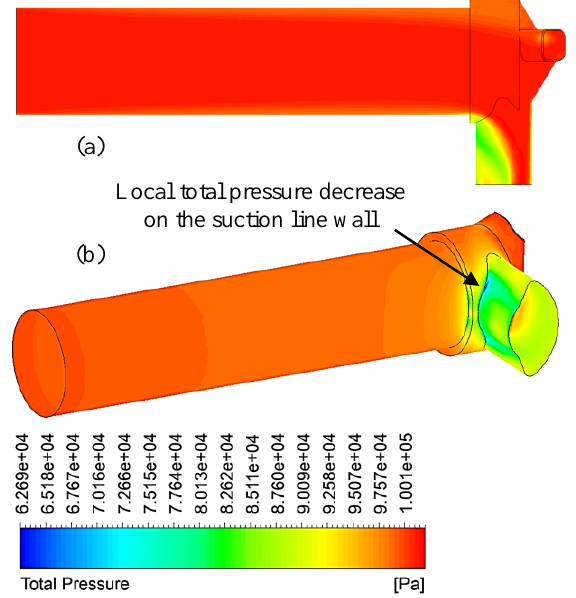
Fig. 8. Total pressure contours in the symmetry plane (a) and the suction line wall (b) for revolutions n p = 3 000 min -1 , oil